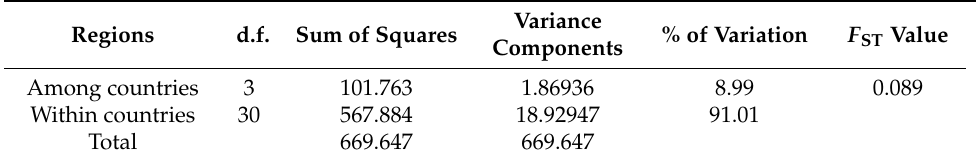
Table 5. The results of the AMOVA of Saprolegnia spp. isolates using 163 AFLP markers; d.f., degree of freedom.